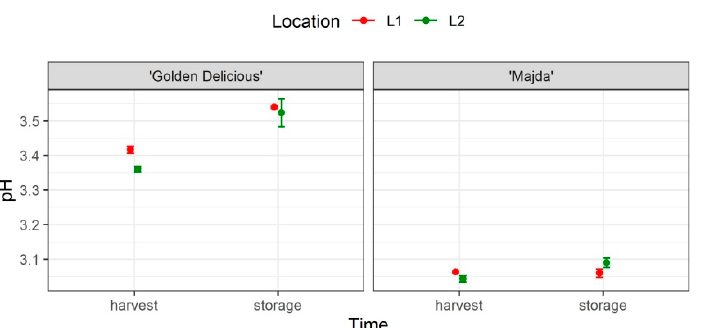
Figure 3. Content of apple juice pH (mean ± SE) of cultivars ‘Golden Delicious’ and ‘Majda’ at two locations (L1 and L2) at harvest and following